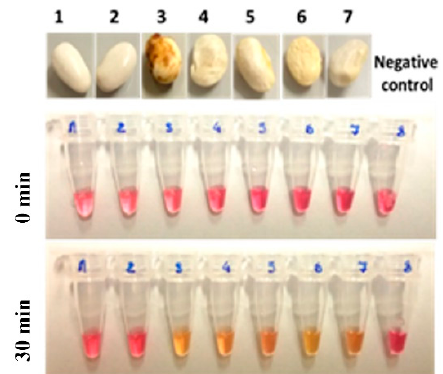
Figure 4. Visual detection of LAMP products obtained with bean seed samples cv. “Pak” for Cff detection. Visual detection of LAMP products from bean seed samples cv. “Pak” for Cff detection. Positive samples show a color change, from pink (negative samples) to yellow. Uninfected (samples 1 and 2) and naturally Cff -infected (samples 3, 4, 5, 6, 7). Molecular grade water was used as a template in negative controls (sample 8).